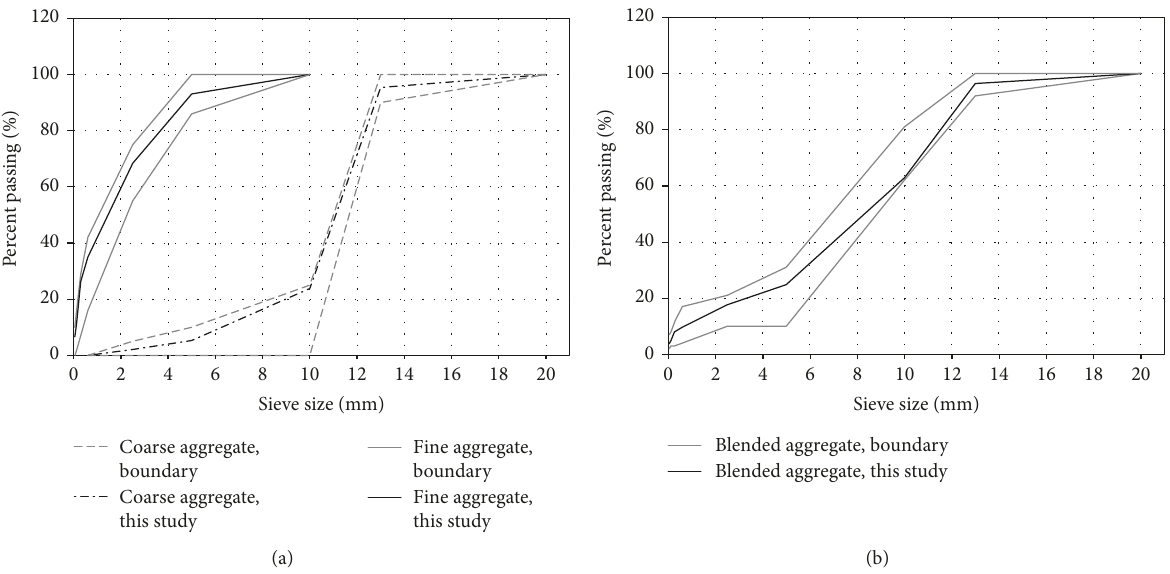
Figure 1: Size distribution and boundary limits of aggregates according to specification. (a) Fine and coarse aggregate grading curve. (b) Blended aggregates grading